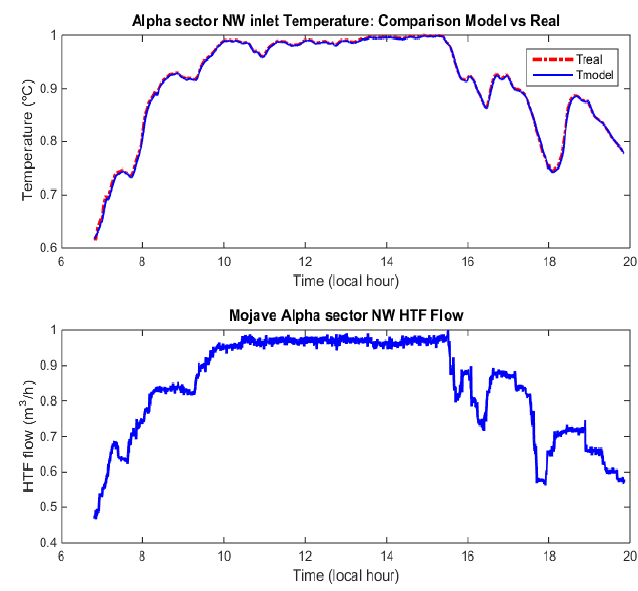
Figure 13. Mojave Alpha, inlet temperature of the North-West sector: ( top ) model (solid blue) and real (red dash-dotted); and ( bottom ) HTF